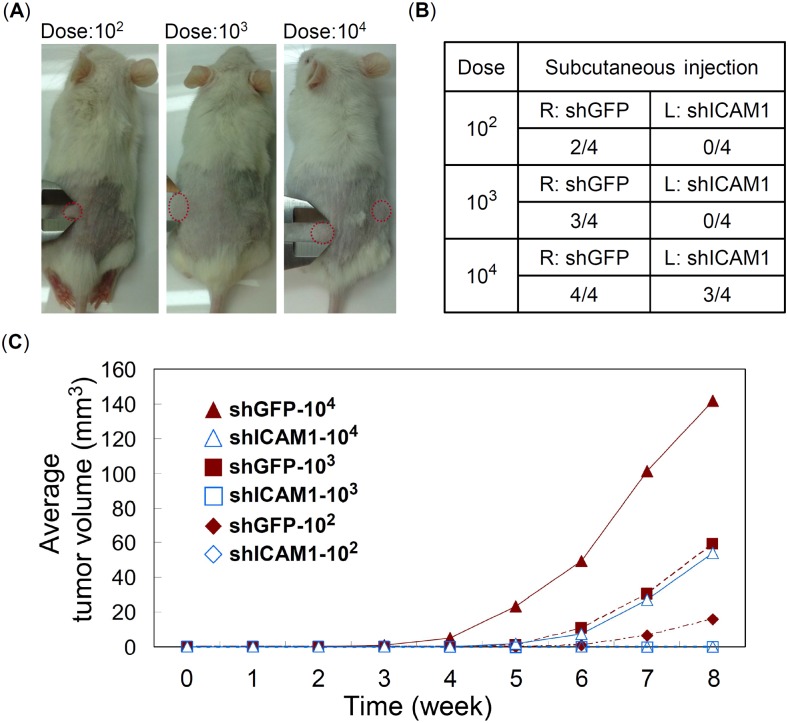
ICAM1 increases tumorigenesis of CE146T.(A) Various doses of CE146T cells, 1x102, 1x103, and 1x104, were injected subcutaneously into both flanks of 5-week-old male NOD-SCID mice (N = 4). Representative subcutaneous tumors derived from CE146T-shGPF in left flank and CE146T-shICAM1#1 in right flank. (B) The number of tumor formation in each group was recorded and summarized. (C) Tumor size was recorded weekly and the average tumor volume of each group was plotted. The observation was continued for eight weeks after inoculation.